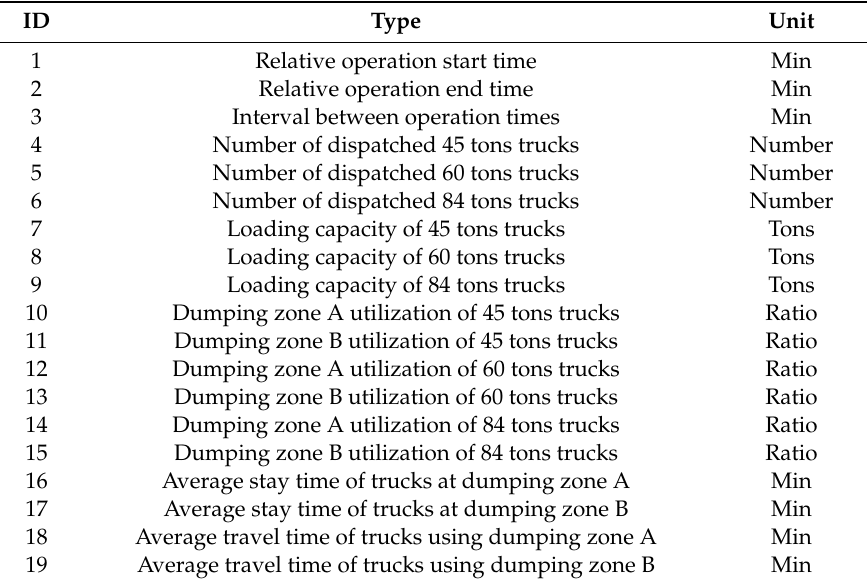
Table 1. Description of input nodes in the proposed DNN